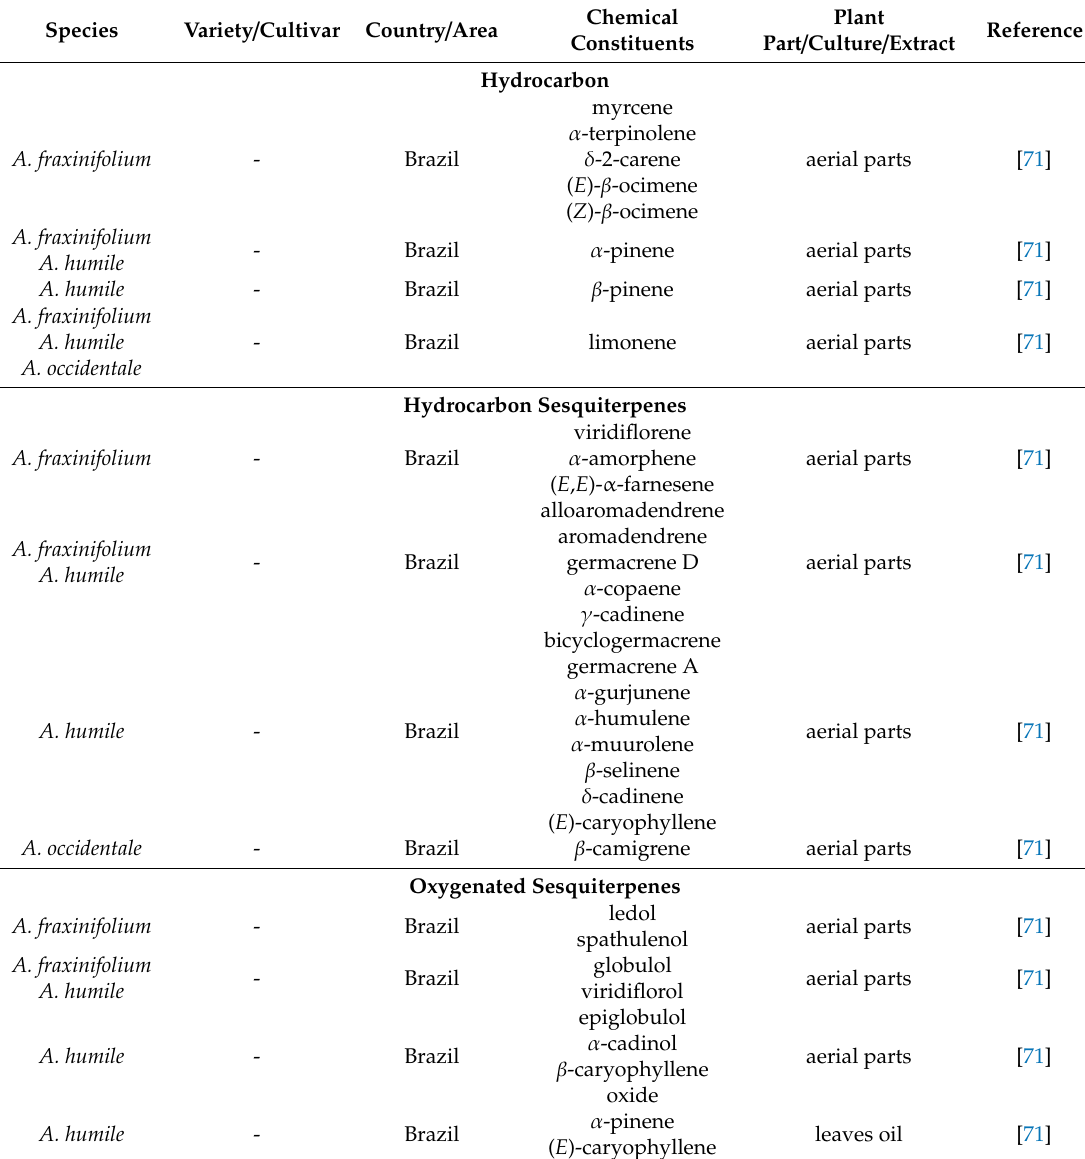
Table 8. Oil constituents in other species of the Anacardeaceae